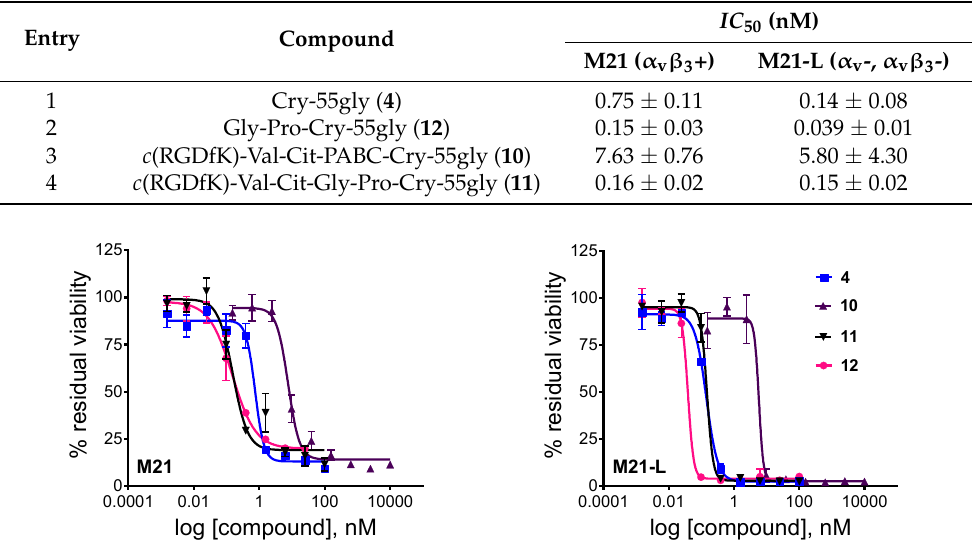
Figure 4. Cytotoxic effect of unconjugated cryptophycin-55 glycinate ( 4 ), conjugates 10 , 11, and metabolite 12 against M21 and M21-L human melanoma cells after 72 h (2 h treatment and additional 70 h incubation). Curves obtained by non-linear regression (four-parameter dose-response, error bars represent the standard deviation of triplicates, the measurements were repeated twice).